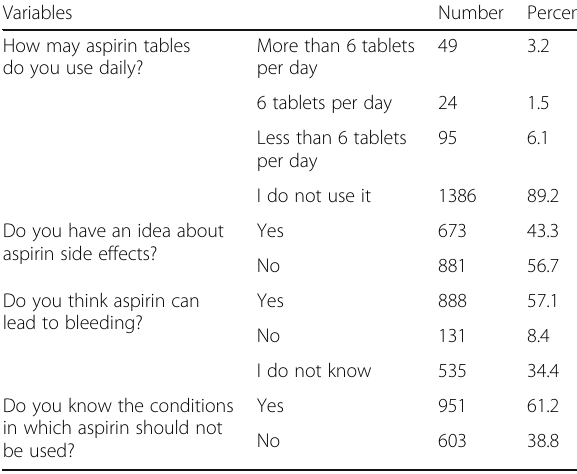
Table 4 Knowledge and awareness of participant about